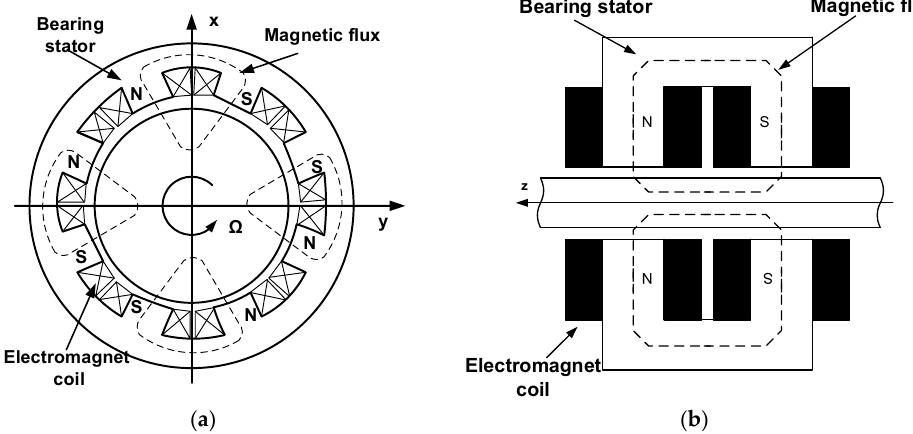
Figure 1. Active magnetic bearing: ( a ) heteropolar magnetic bearing, ( b ) homopolar magnetic bearing.